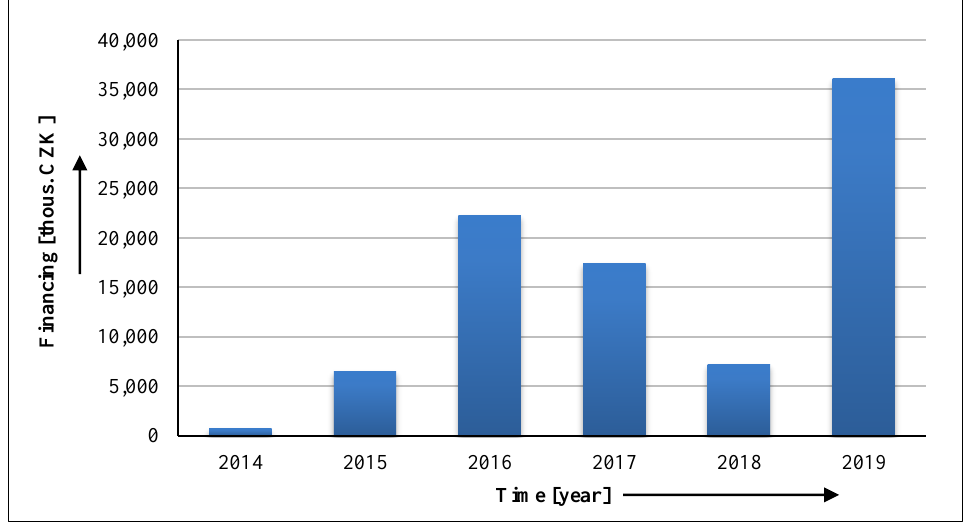
Figure 5. Funds transferred from the decision of the MFCR to the budget of the Zlín Region regarding Vrbětice emergency in 2014–2019